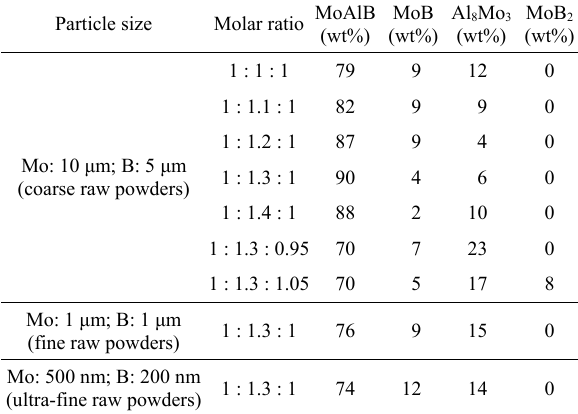
Summary of compositions and processing conditions of MoAlB samples using Mo/Al/B powder mixture as starting materials